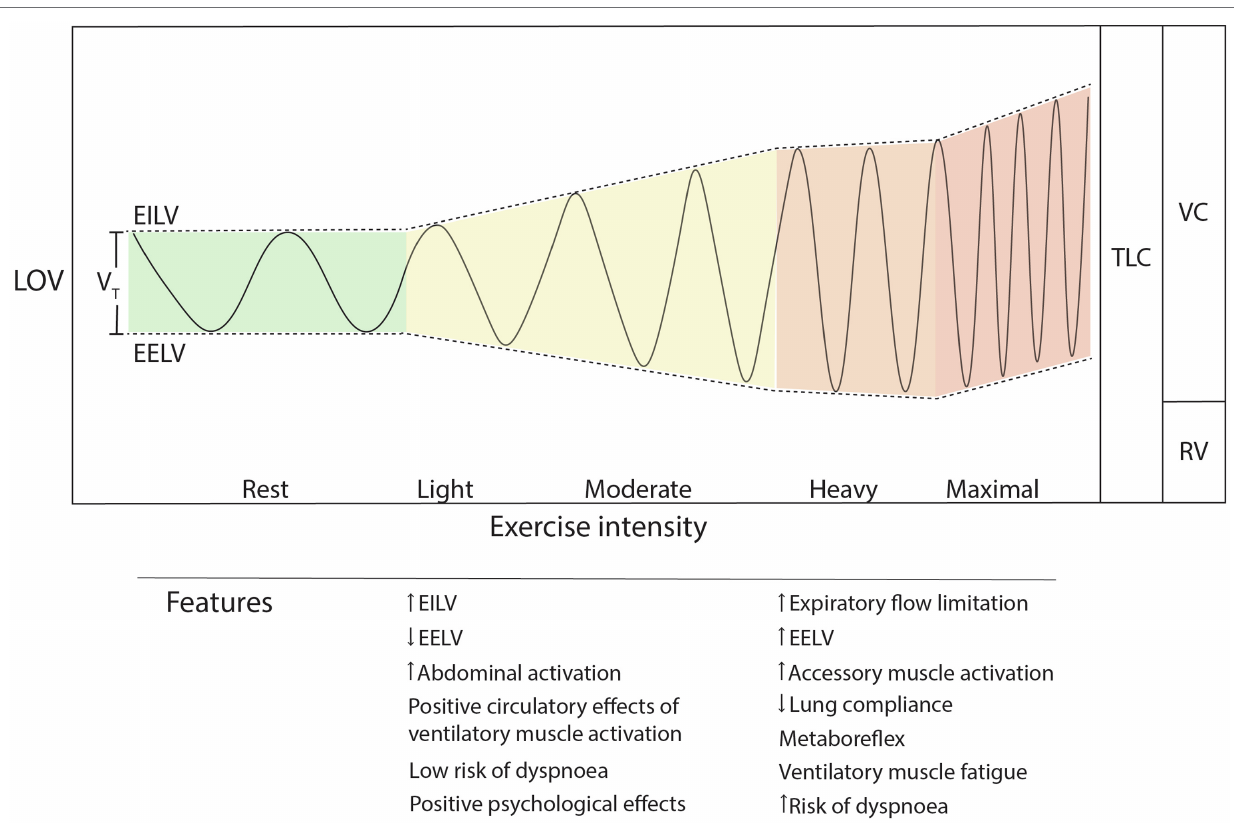
FIGURE 1 | Exercise breathing pattern changes during increasing exercise intensity. Note the nonlinear increase in breathing rate and unequal partitioning of EILV and EELV as intensity increases. TLC, total lung capacity; LOV, lung operating volume; VC, vital capacity; RV, residual volume; EILV, end-inspiratory lung volume; EELV, end-expiratory lung volume; and V T ,